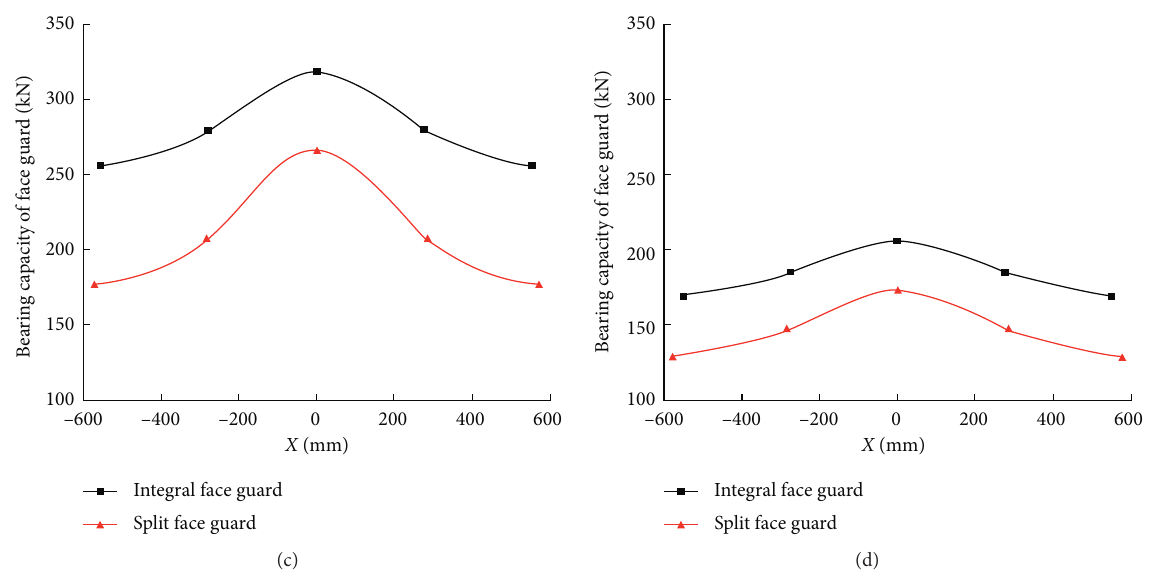
Figure 15: Comparison of the bearing capacities of different positions of face guard. (a) Coordinate value of X -axis is 280mm. (b) Coordinate value of X -axis is 560mm. (c) Coordinate value of Y -axis is 840mm. (d) Coordinate value of Y -axis is 1300mm.